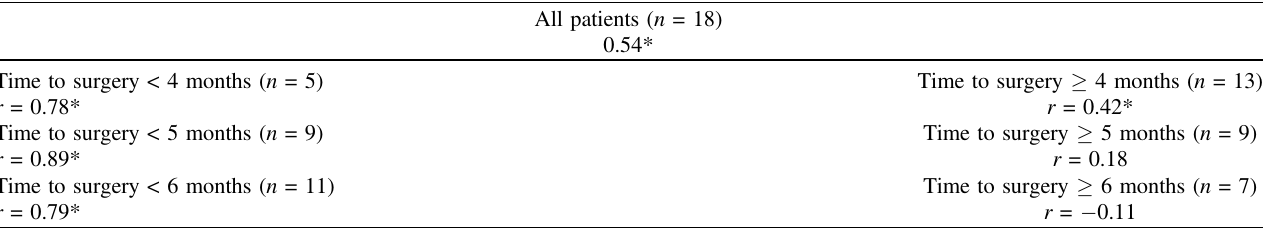
Table 2. Correlations between the intrascaphoid angle (ISA) and scapholunate angle (SLA).